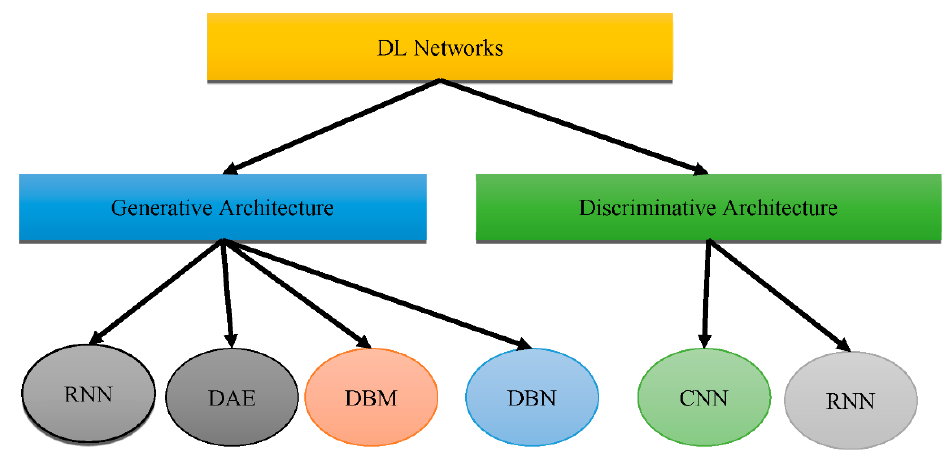
Figure 1. Types of DL architectures.